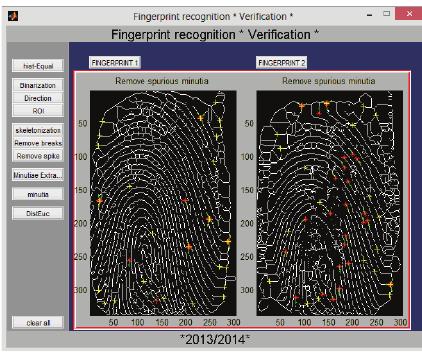
Figure 9: GUI of the verification process in the fingerprint mono- modal recognition system.